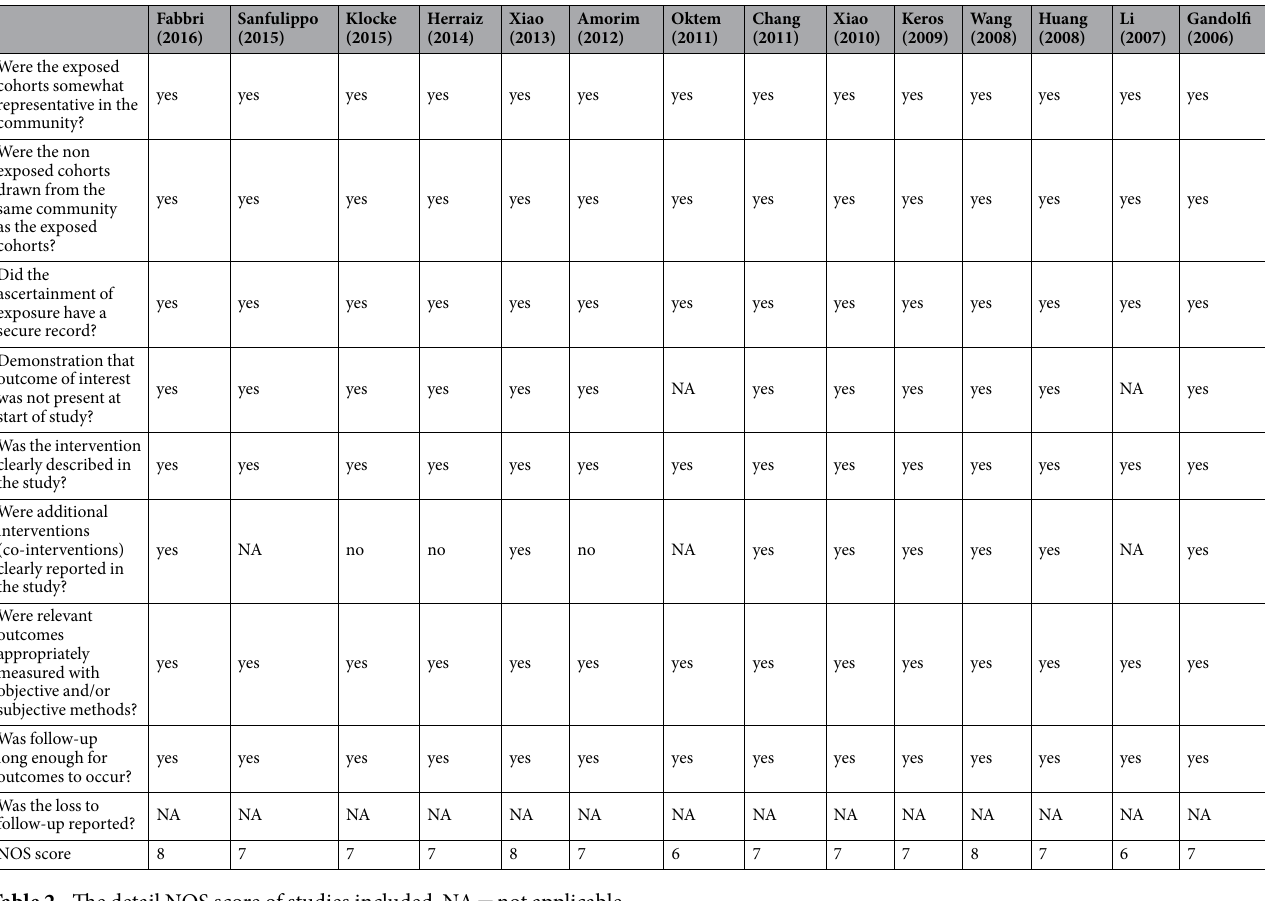
Table 2. The detail NOS score of studies included. NA = not